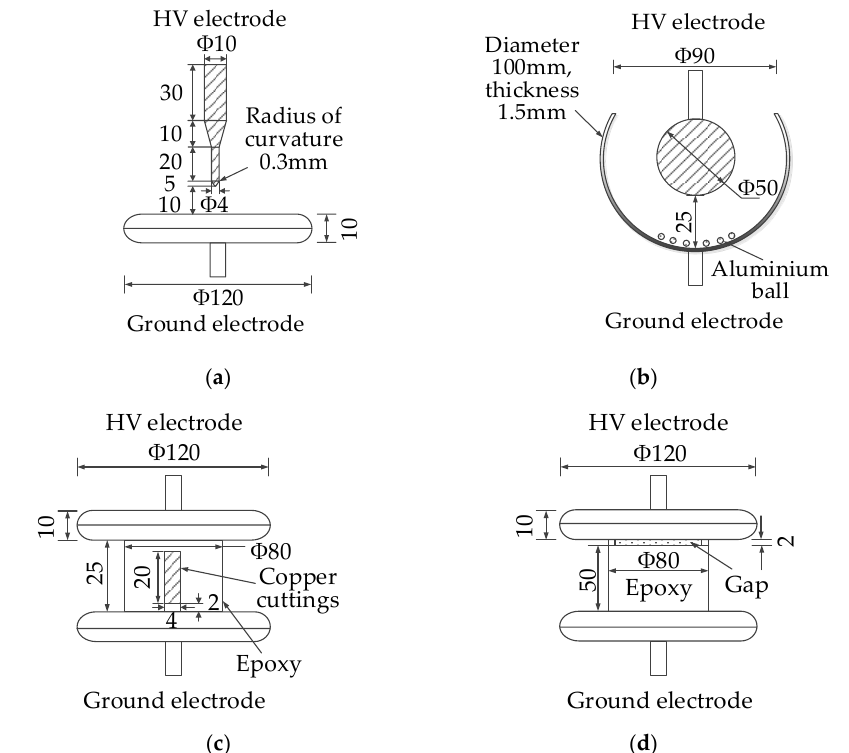
Figure 4. Four kinds of insulation defect models (Unit: mm): ( a ) Protrusion defect; ( b ) Particle defect; ( c ) Pollution defect; and ( d ) Gap defect.